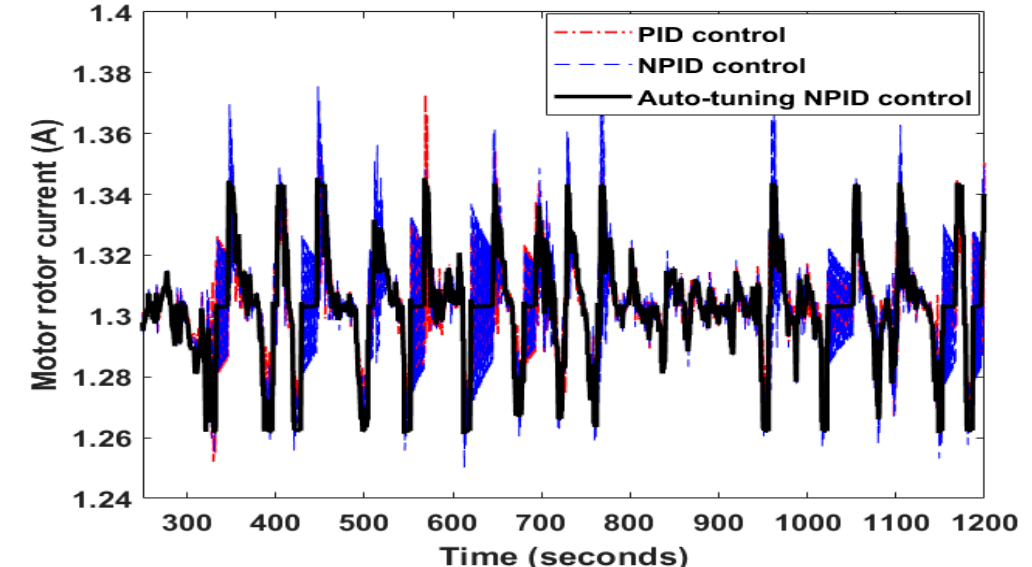
Figure 8. The corresponding currents of the PID, NPID, and auto-tuning NPID to track the NEDC speed test.